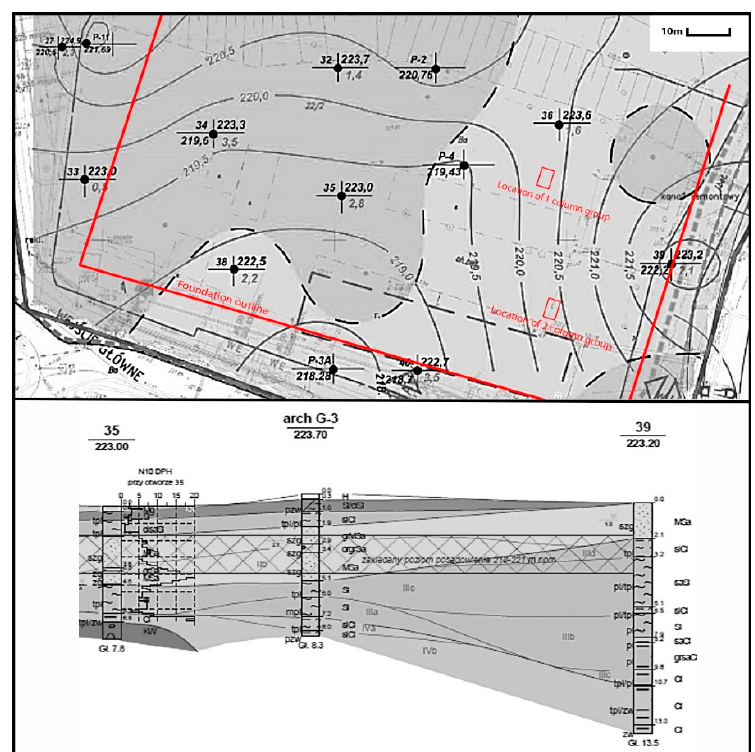
Figure 3. A fragment of a documentary map with the location of geological boreholes, location of foundation and location of column group No. 1 and 2.